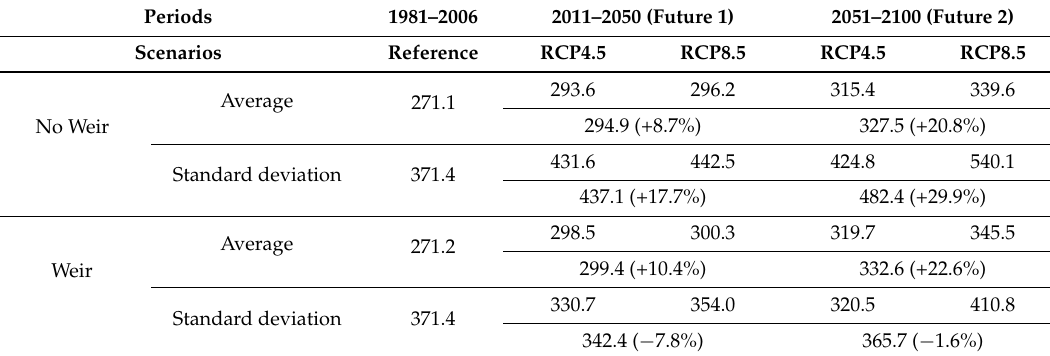
Table 7. Changes in indicators of hydrologic alteration (HA) analysis at the Gyuam site.